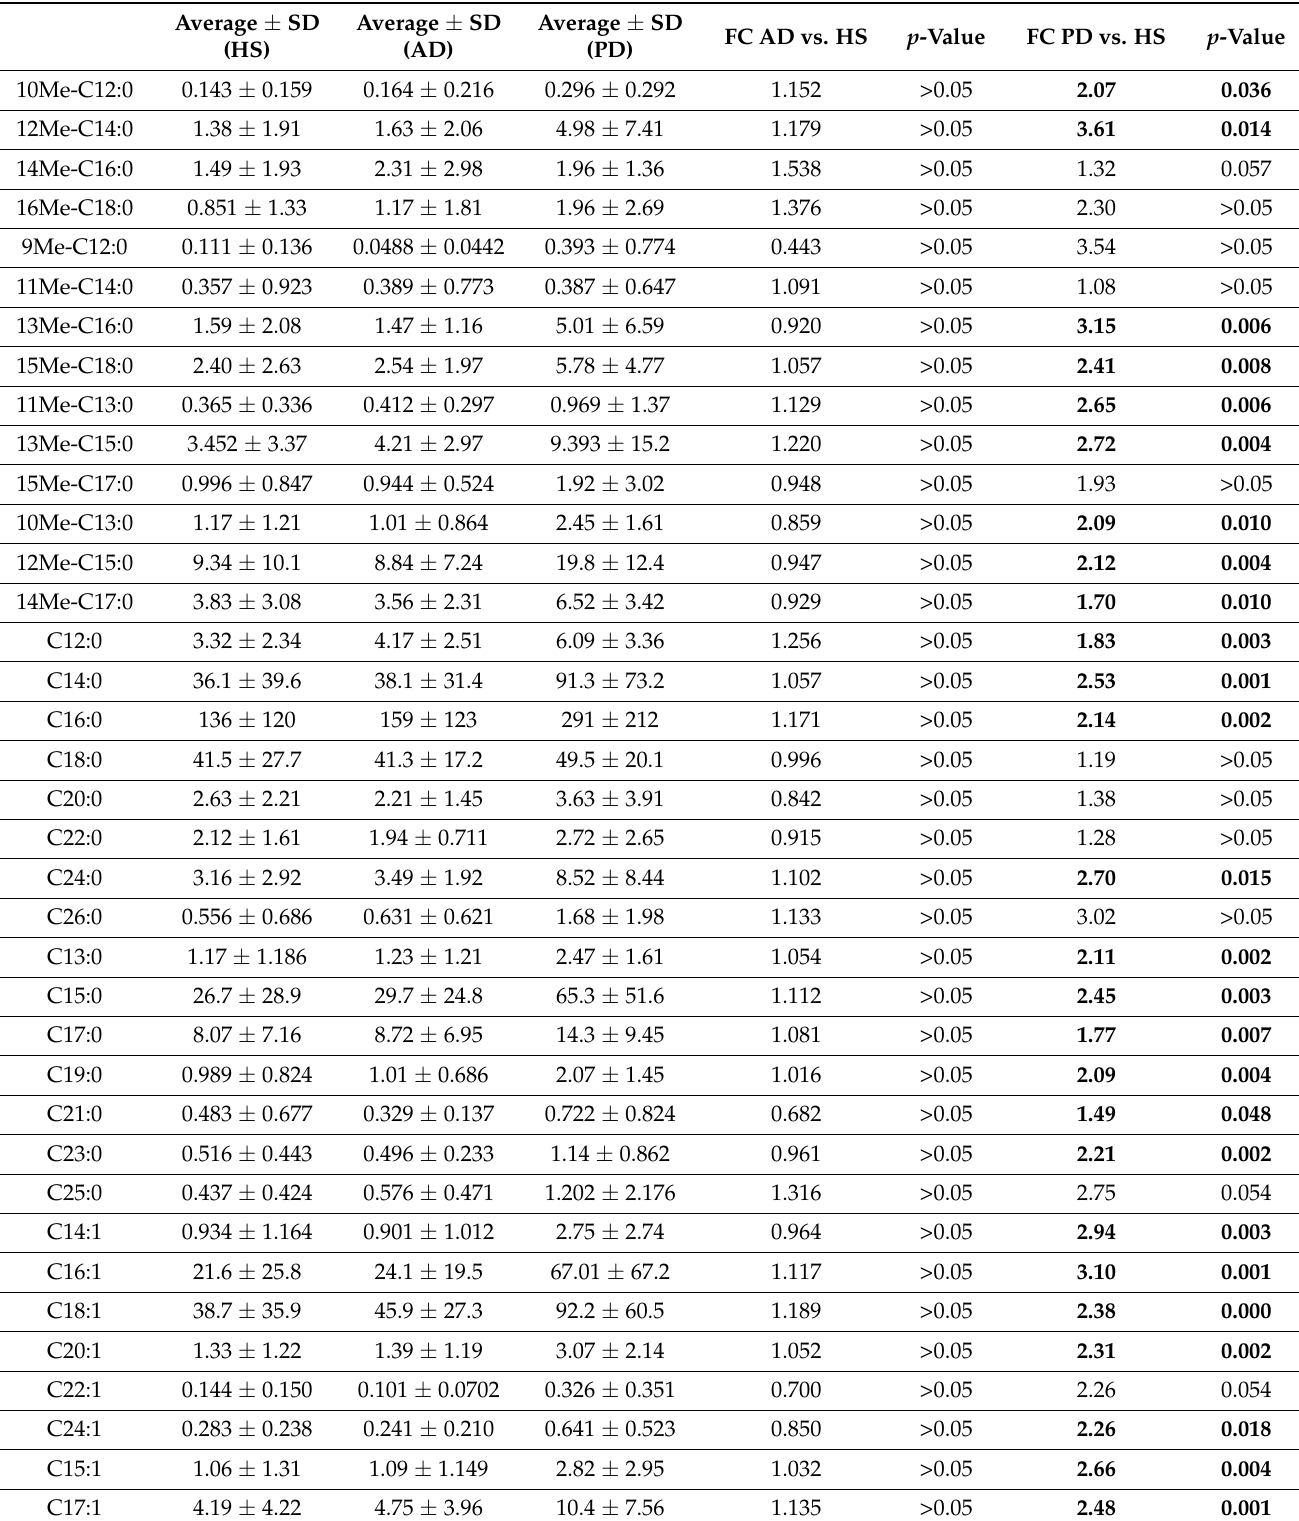
Table 2. The table reports the amounts of sebum lipids ( µ g) quantified in sebum sampled in 30 min from two Sebutape patches. Results are reported as average ± standard deviation (SD). Mann–Whitney test was used for the comparison between HS and each AD and PD groups. Fold changes (FC) of averaged values in the AD or PD group vs. controls were in bold when p -values were